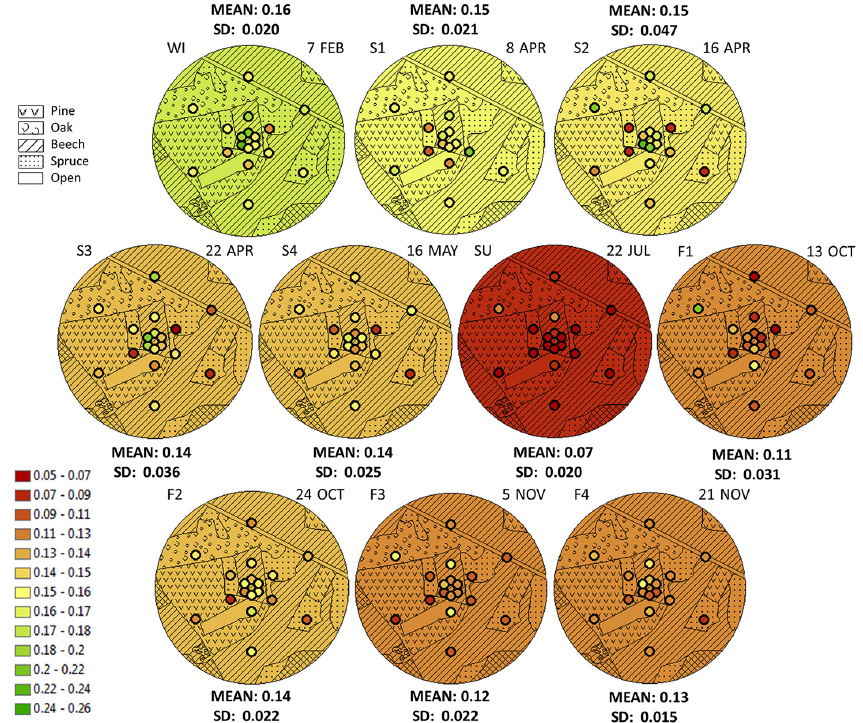
Figure 3. Gravimetrically determined volumetric soil water content patterns in the footprint of the CRS for the 10 calibration dates. The col- ored dots indicate the unweighted average value from 0 to 30cm at the 18 calibration locations. Background colors represent the unweighted average value of all 108 soil samples. Different forest stands (pine, beech, oak, spruce) are indicated by the patterned